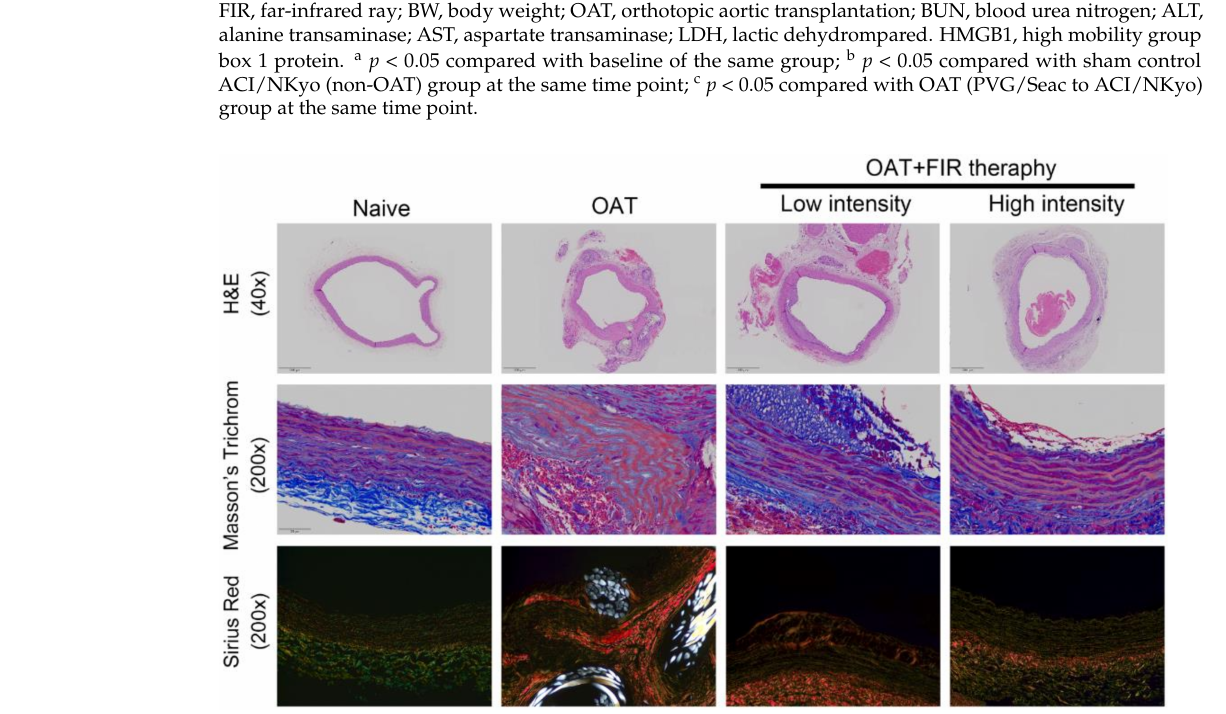
Figure 1. FIR therapy reduced allograft vasculopathy in OAT-recipient ACI/Nkyo rats. (upper column) Thoracic aortas from donor PVG/Seac rats stained with hematoxylin and eosin. The arrows indicate internal elastic lamina and arrowheads indicate calcified lesions. The images are 40 × magnified. (middle column) The integrity of collagen fibers of thoracic aorta cross-sections was observed using Masson’s trichome staining. (lower column) Histopathological features and collagen accumulation of thoracic aorta cross-sections were observed using picrosirius red staining. The slides were observed via light microscopy and polarized light microscopy, respectively (200 ×